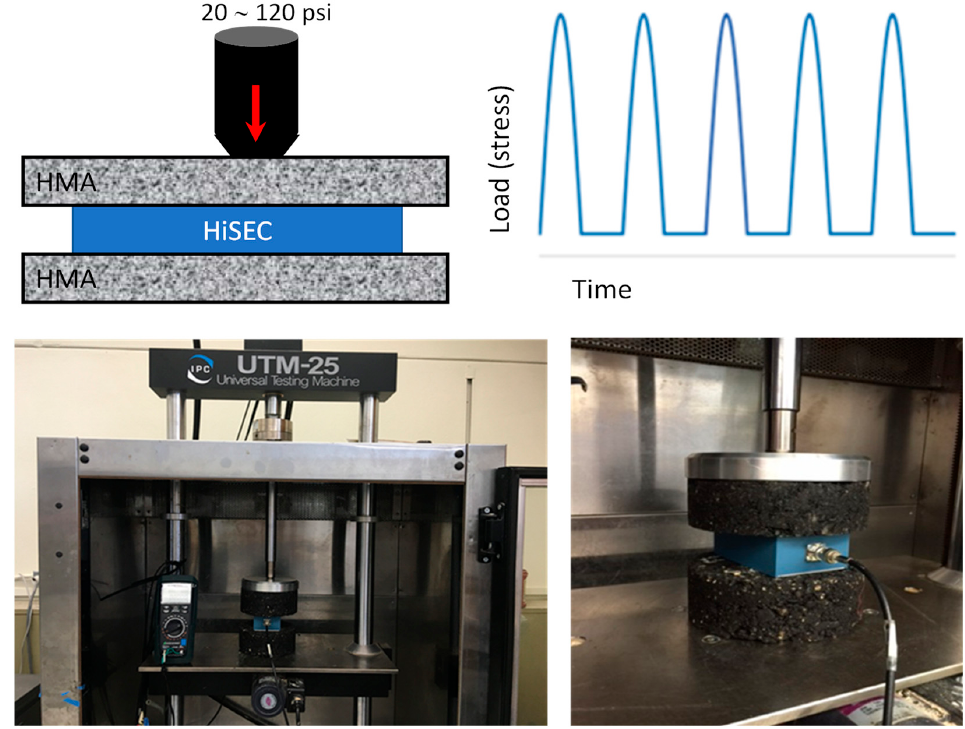
Figure 4. The UTM Loading Configuration and HiSEC Module